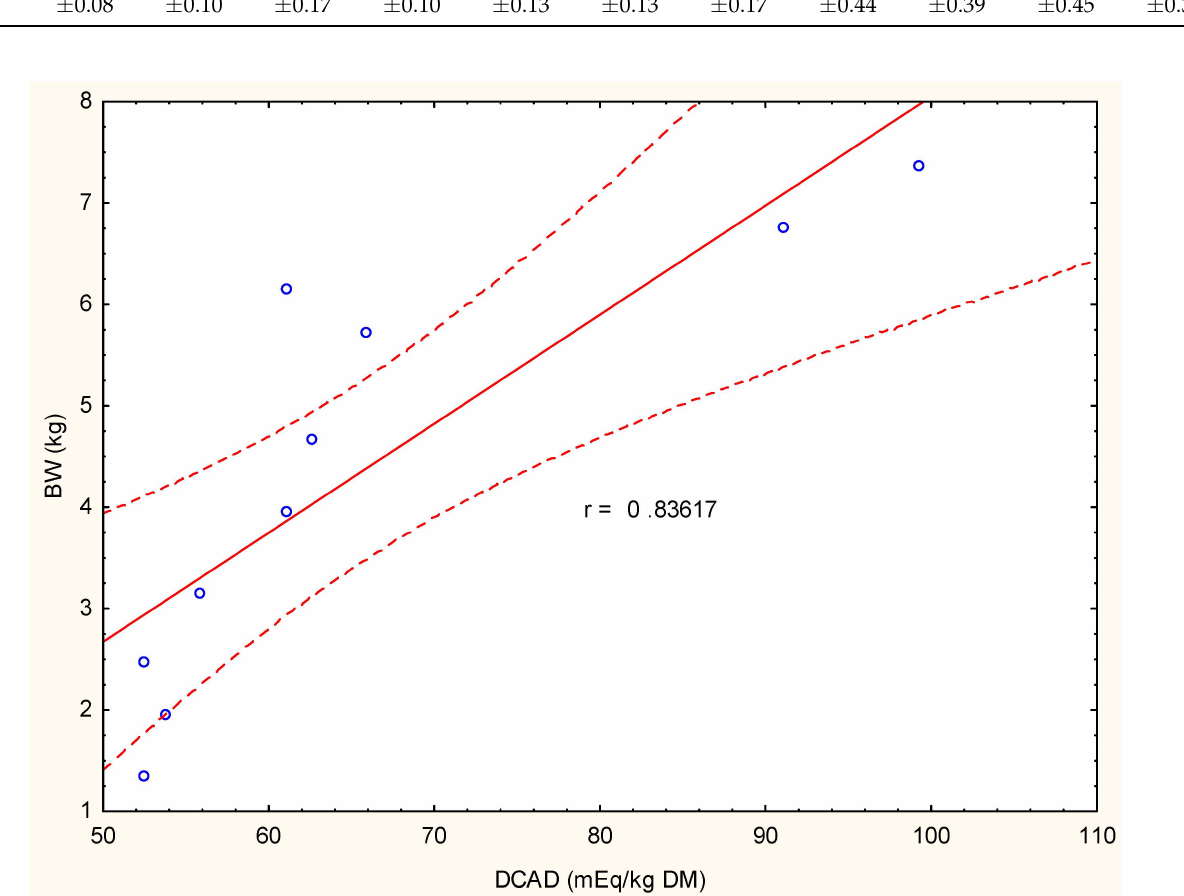
Figure 2. High positive correlation (r = 0.830) between BW and DCAD value in the group of birds fed the standard diet (60%), corn silage (40%) plus 240 g of CaCl 2 per 100 kg of diet (i.e., group B). Estimation was performed with Statistica 13 (StatSoft, Poland) using linear Pearson matrix correlation